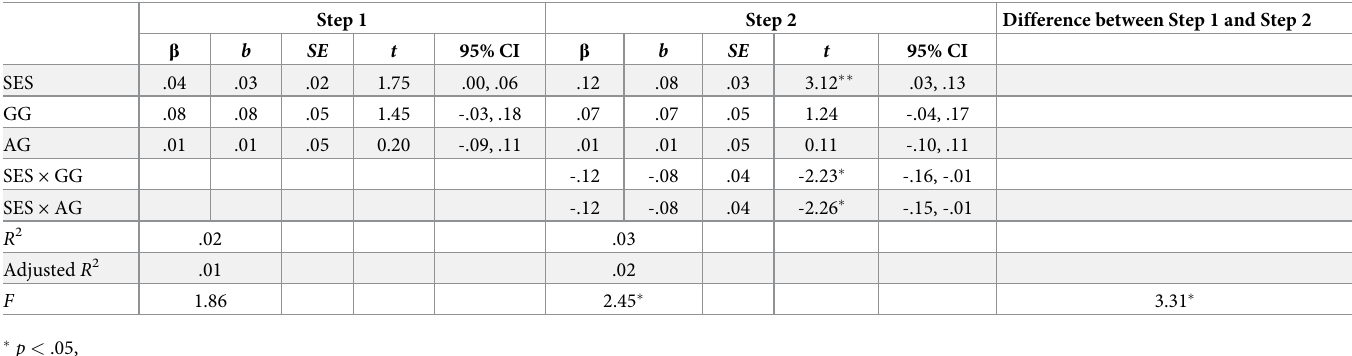
Table 6. Hierarchical regression results for adaptive coping (with AA genotype as